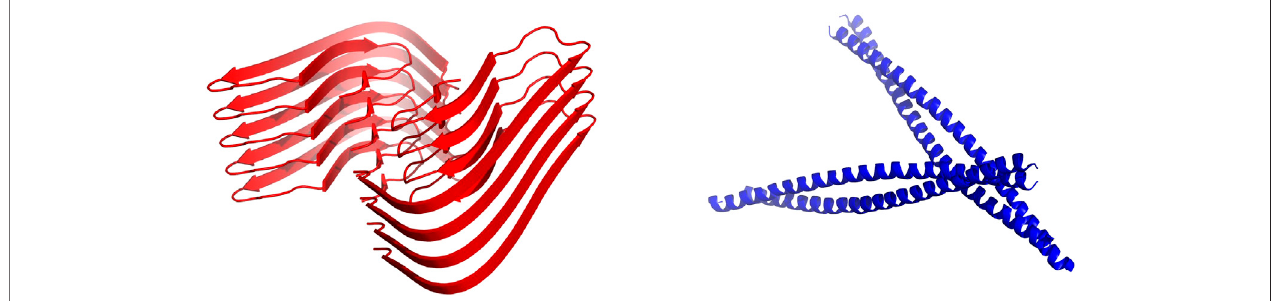
FIGURE 1 | Structural building blocks of amyloid based and coiled-coil based IBs. Schematic representation of cross- β -sheet (red, according to PDB: 5OQV) and coiled-coil (blue, according to PDB: 2JEE) structures. They intend to illustrate the kind of scaffolds sustaining amyloid and coiled-coil based IBs.